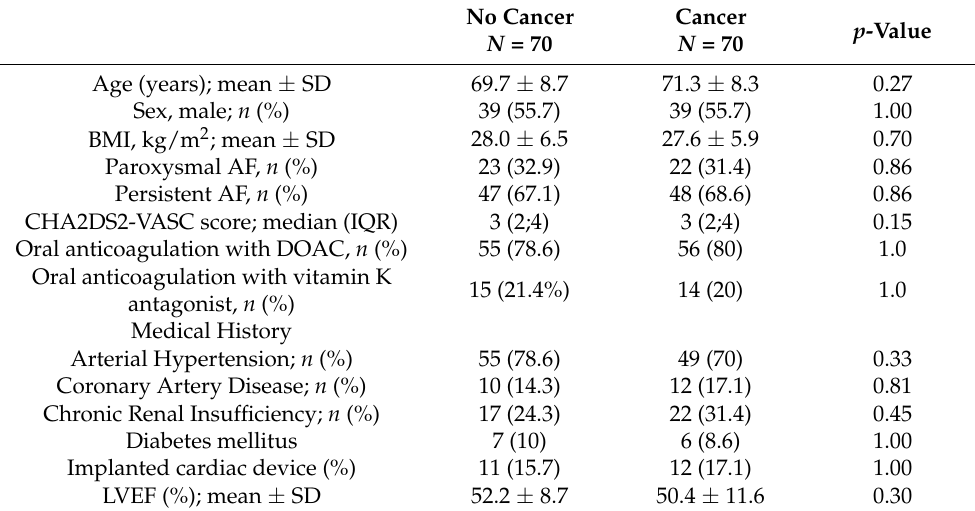
Table 1. Baseline characteristics of patients with and without cancer